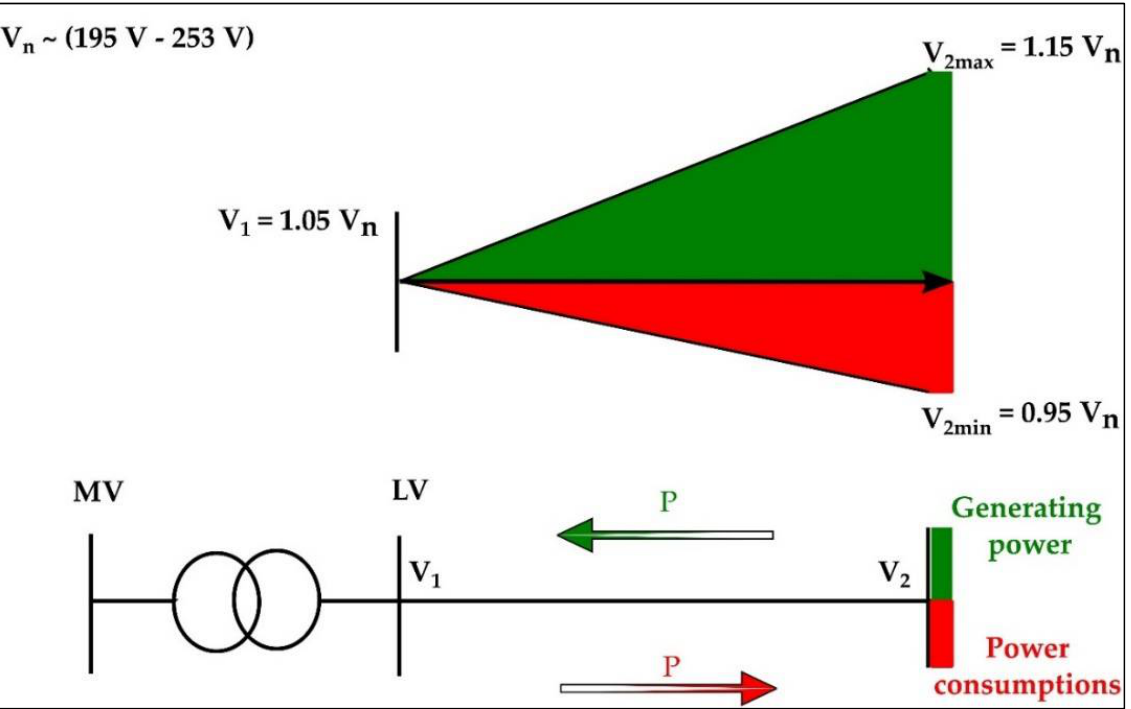
Figure 3. Voltage at the microgrid system input when supplying and returning power to the grid.